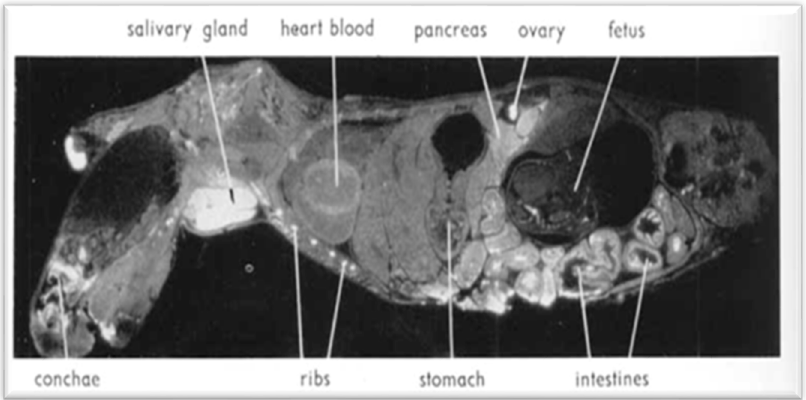
Figure 5. Autoradiogram showing 137- Cs distribution in a pregnant mouse 6 h after intravenous injection. White areas correspond to high radioactivity. Uptake is high in the salivary gland, pancreas, and intestine. In fetuses, concentration is significantly lower than in the mother. In the pancreas, the islets of Langerhans appear to have a slightly lower activity than the acinar tissue. (Reproduced from Nelson et al. [13] with permission of Acta Radiologica, 1961).